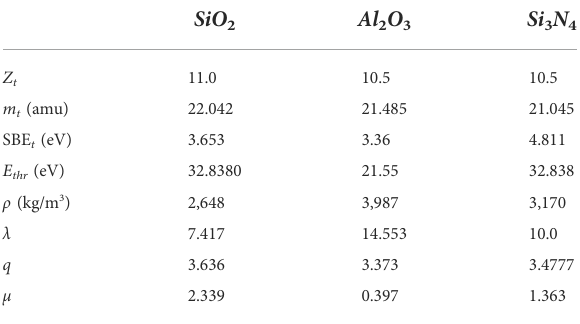
TABLE 4 Fitting parameters chosen to represent SiO 2 , Al 2 O 3 and Si 3 N 4 withinthesputteringestimationmodelspresentedinFigure5.The values for the material properties and the fi tting parameters were obtained through a combination of averaging and optimization techniques, as described in subsection